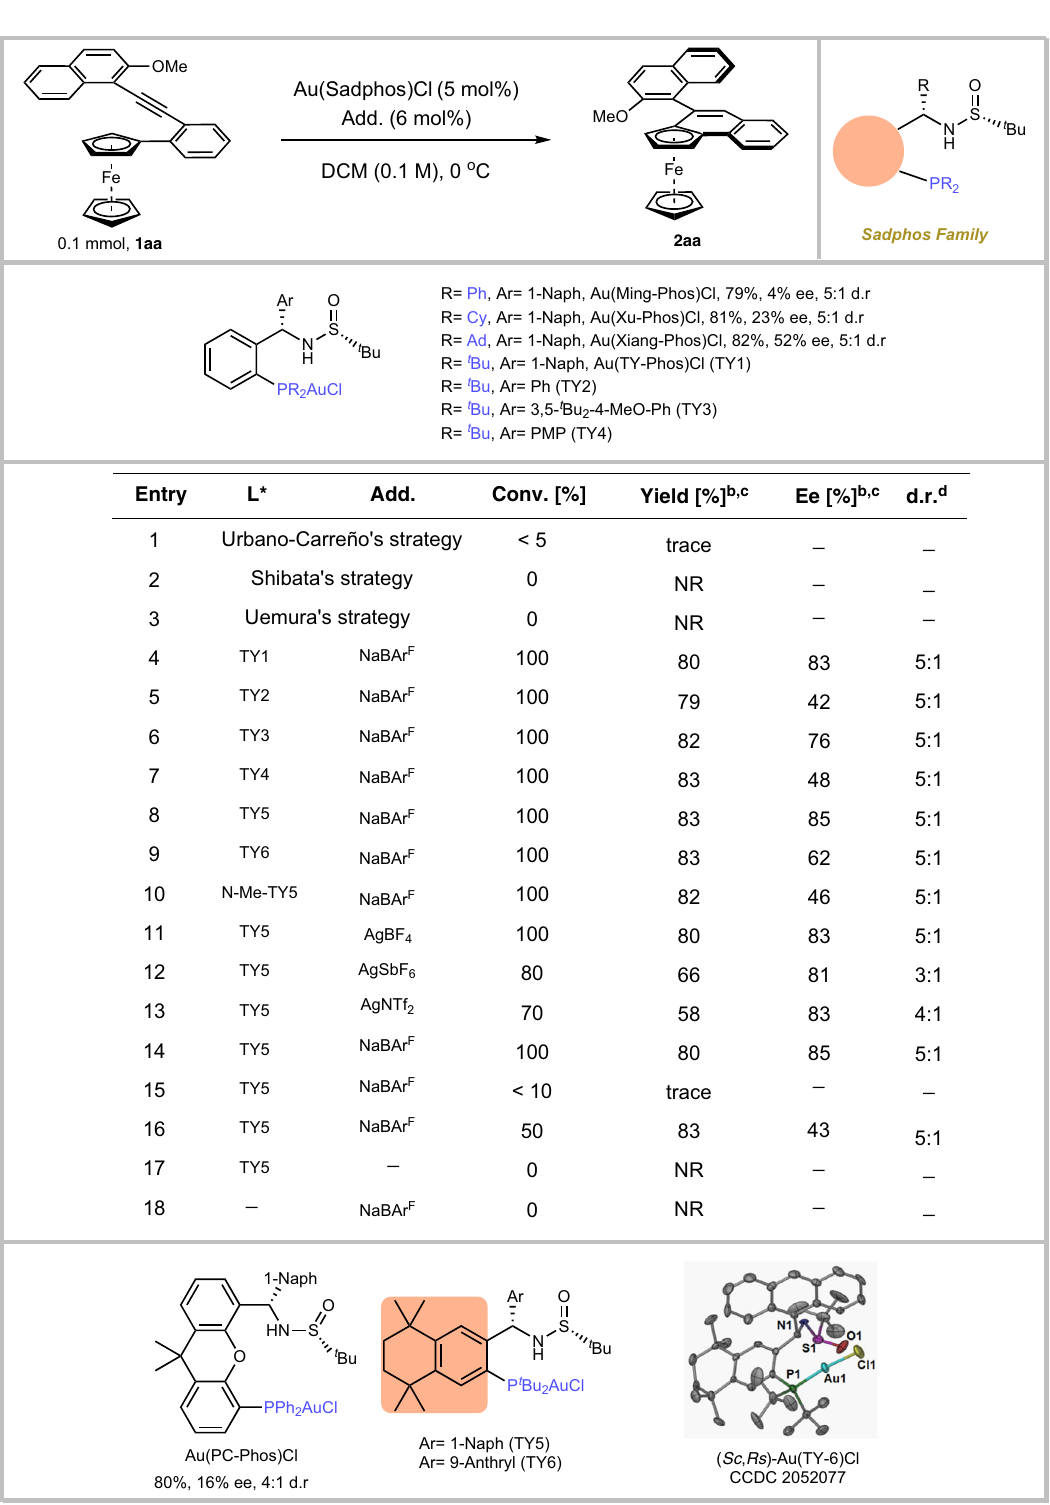
NATURE COMMUNICATIONS| (2021) 12:4609